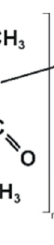
Figure 5. The chemical structure of PMMA.